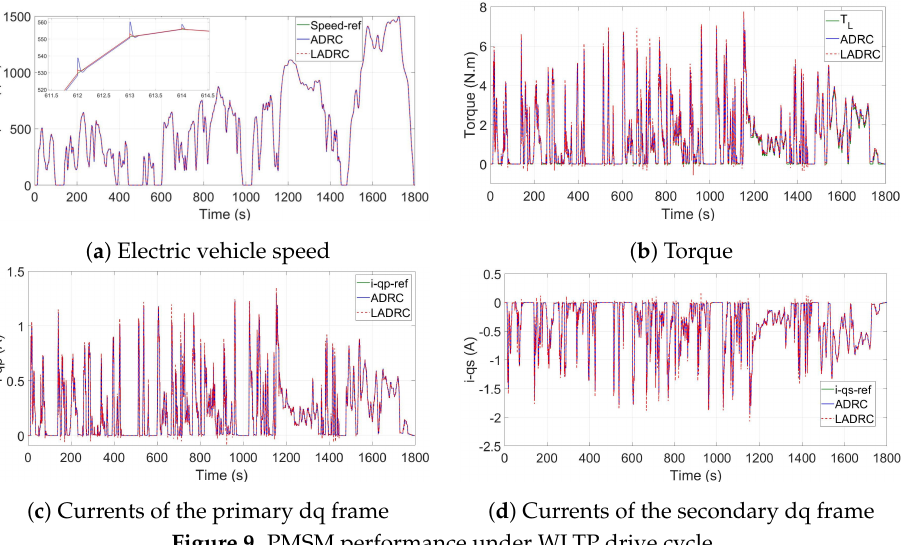
Figure 9. PMSM performance under WLTP drive